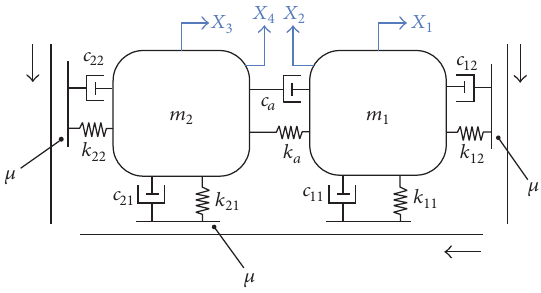
Figure 1: Mechanical model under